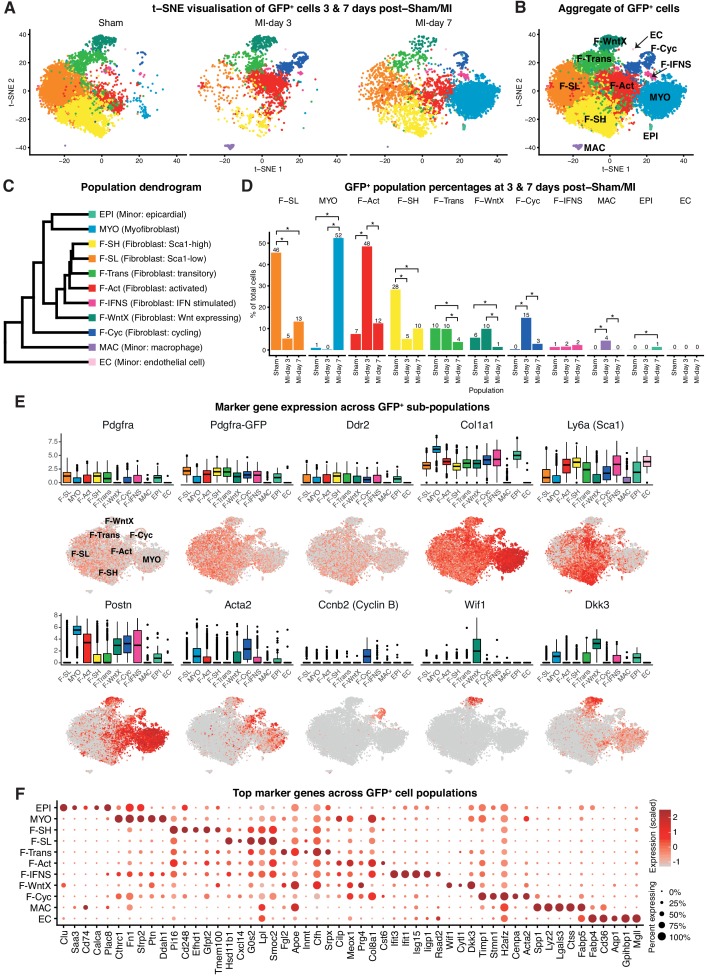
Pdgfa-GFP+ scRNA-seq.(A) t-SNE plot of GFP+ cells separated according to experimental condition (sham, MI-day 3, MI-day 7). (B) t-SNE plot showing aggregate of GFP+ cells across conditions. (C) Dendrogram of populations determined by average RNA expression in populations. (D) Percentages of cells in each population according to experimental condition. Stars indicate significant change across conditions according to DPA (p<0.01). (E) Expression of select genes in different populations as visualized in box and t-SNE plots. (F) Dot-plot of top five upregulated genes for each population where color indicates strength of expression and size of dot represents percentage of cells expressing the gene.10.7554/eLife.43882.023Figure 4—source data 1.Source data for quantification of colony counts summarized in Figure 4—figure supplement 2E.